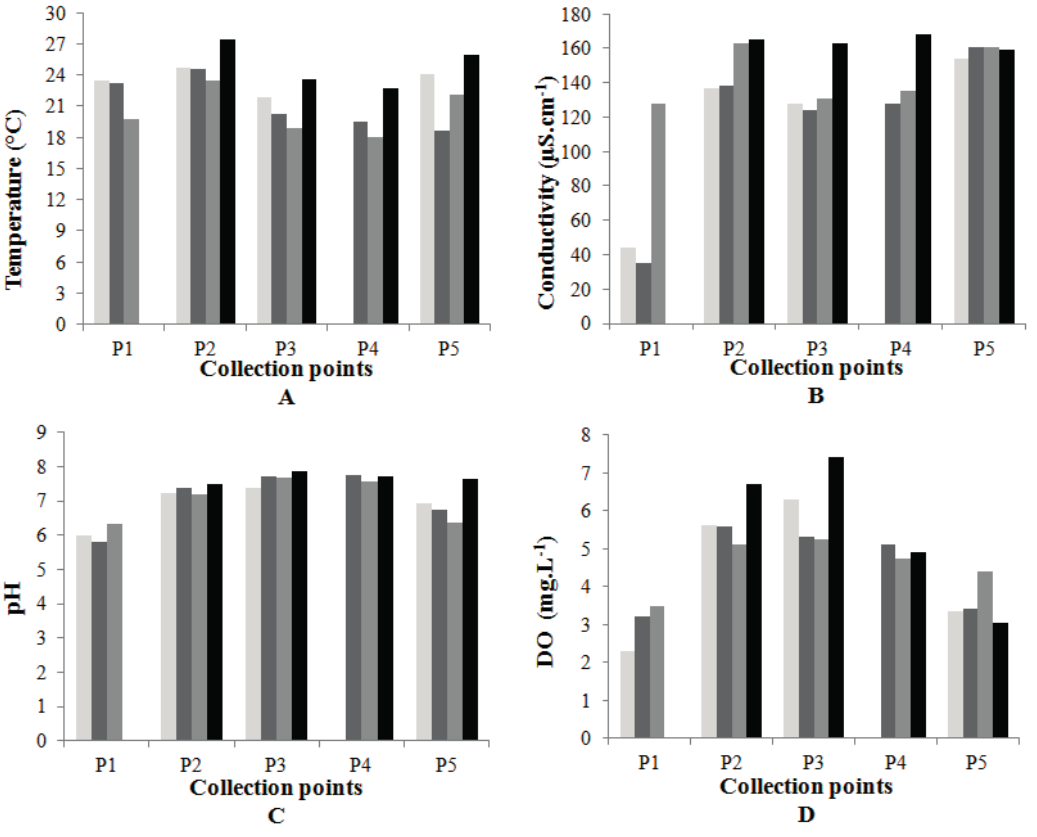
Figure 3. ( A ) Temperature; ( B ) Electrical conductivity; ( C ) hydrogen ion potential and ( D ) dissolved